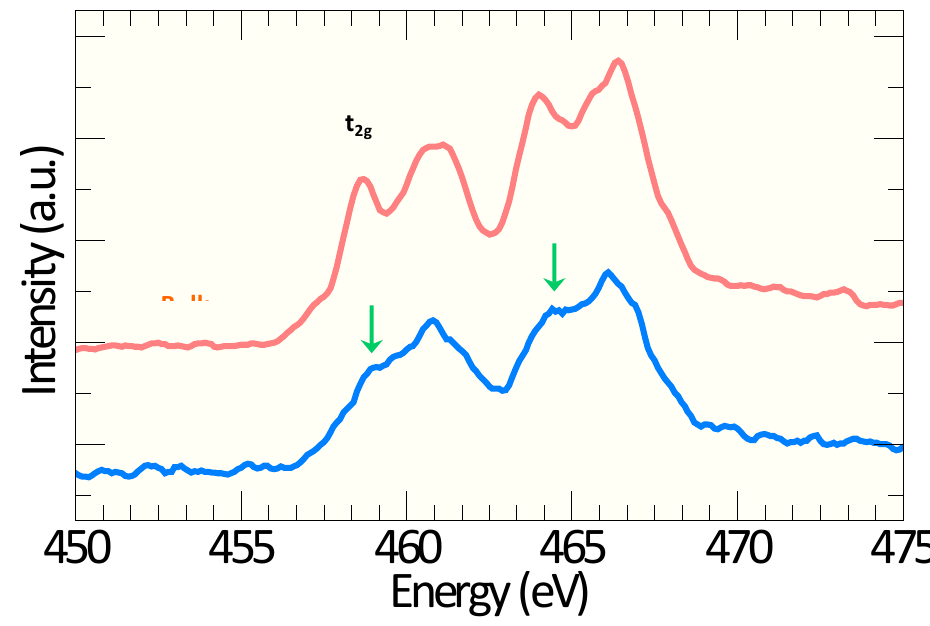
Figure 27. The Ti-L 2,3 edge EELS profiles obtained from the dislocation core and in the bulk region (i.e. , away from the core). The region used to represent the TiO 2 bulk is 10 nm far from the exact dislocation core [32].